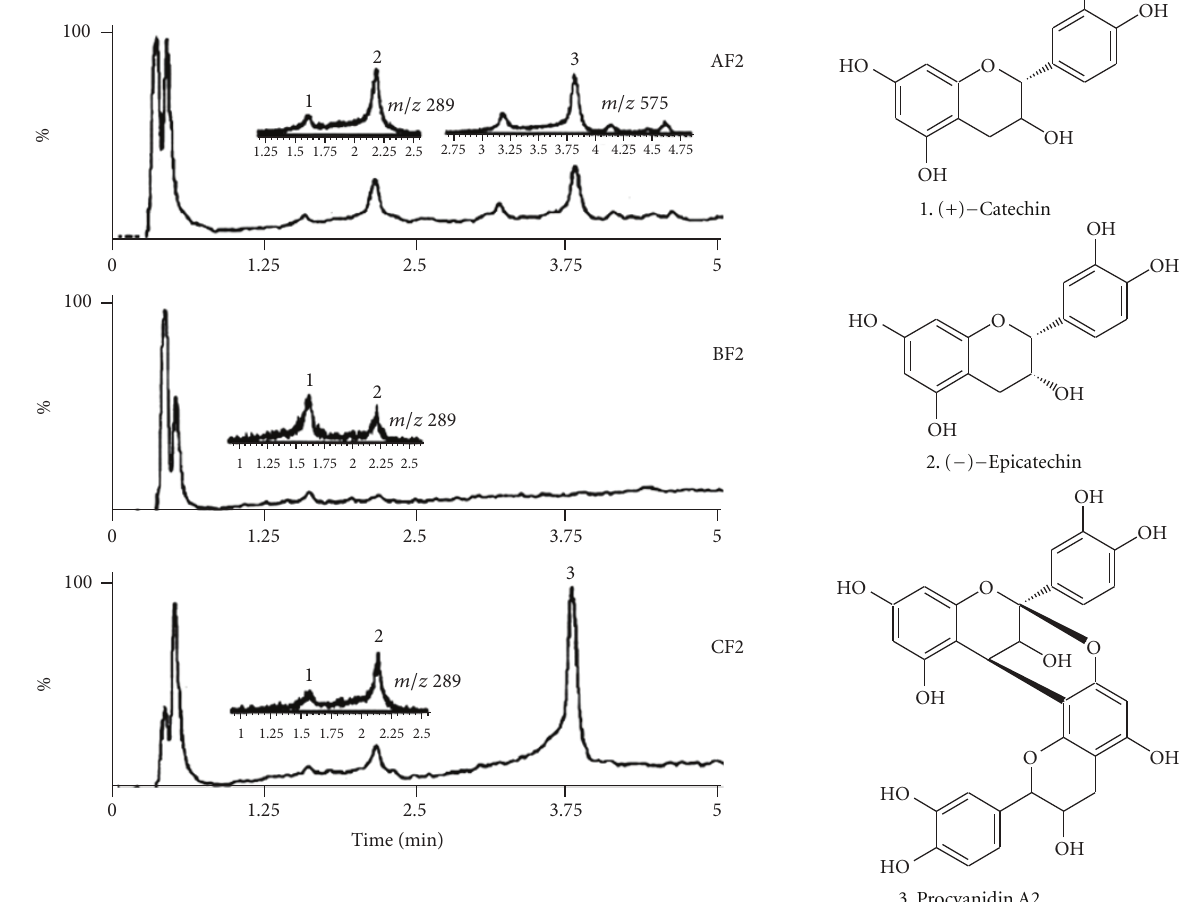
F 2: Analysis of terminal units of highly polymeric proanthocyanidins from three food sources using the individual fractions of F2 aer thiolytic cleavage by